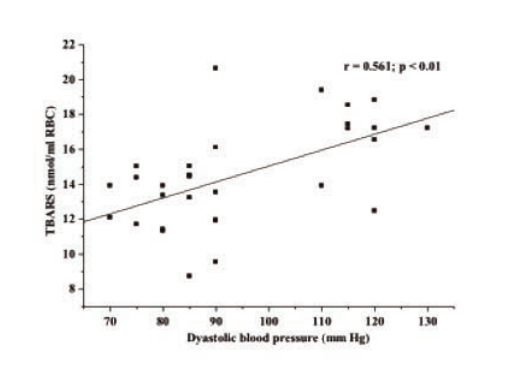
Figure 4. Correlation between TBARS in RBC and diastolic pressure.